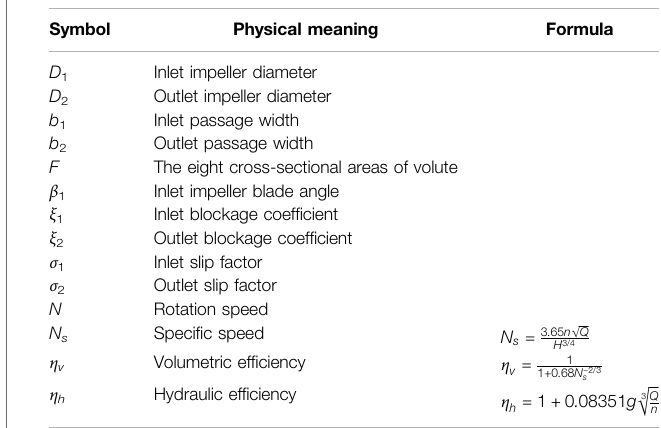
TABLE 2 | Parameters in performance prediction method of rotor – volute matching